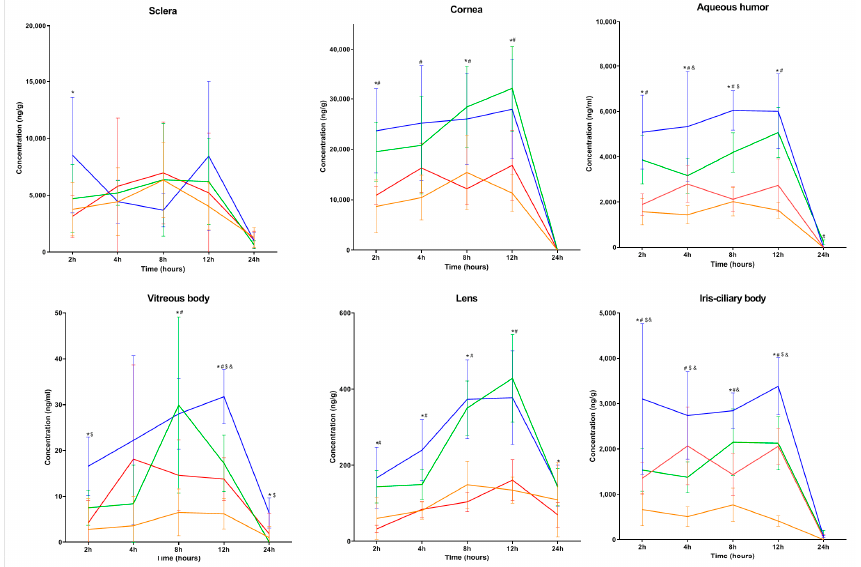
Figure 2. Concentration-time values of gatifloxacin in ocular tissues and plasma. Each point repre- sents the mean concentration ( n = 5–6). ±: the standard error of the mean. *: The difference was sta- tistically significant between groups A1 and B1; #: The difference was statistically significant be- tween groups A2 and B2; $: The difference was statistically significant between groups A1 and A2; &: The difference was statistically significant between groups B1 and B2 ( p < 0.05). Table 4. AUC 0-24 values of gatifloxacin in ocular tissues and plasma. Biological